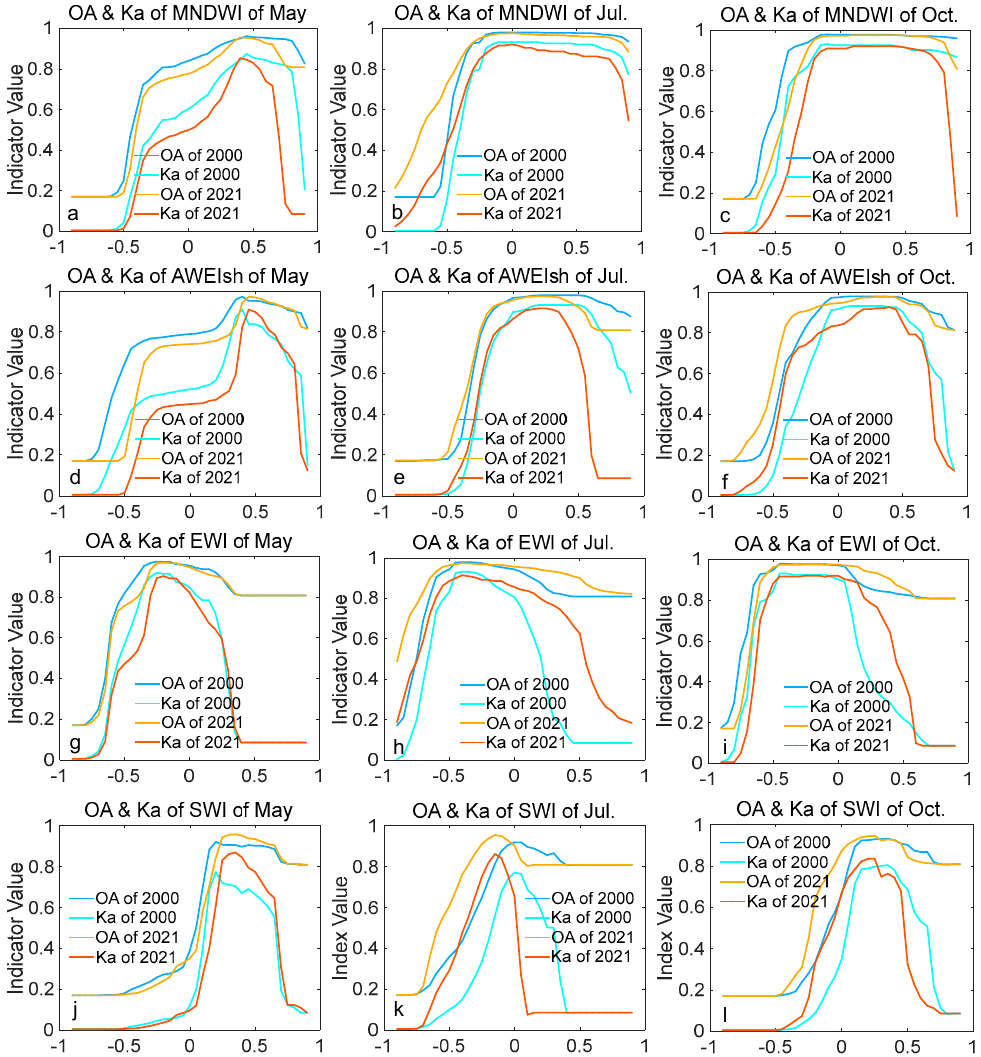
Figure 7. OA and the Ka of water classi fi cation of MNDWI ( a – c ), AWEIsh ( d – f ), EWI ( g – i ) and SWI ( j – l ) of di ff erent water periods based on di ff erent segmentation